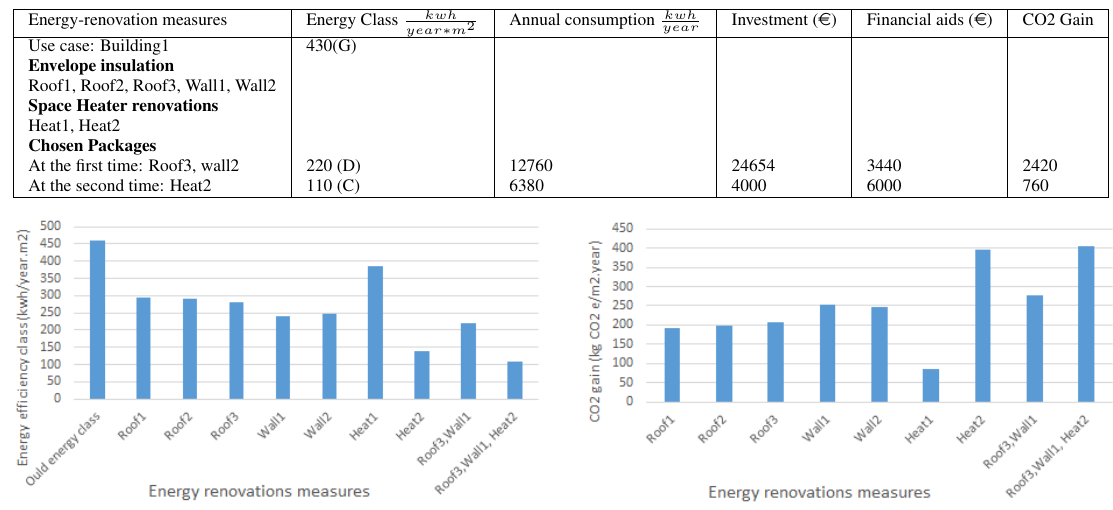
Table 5. Influence of energy renovation packages on one building